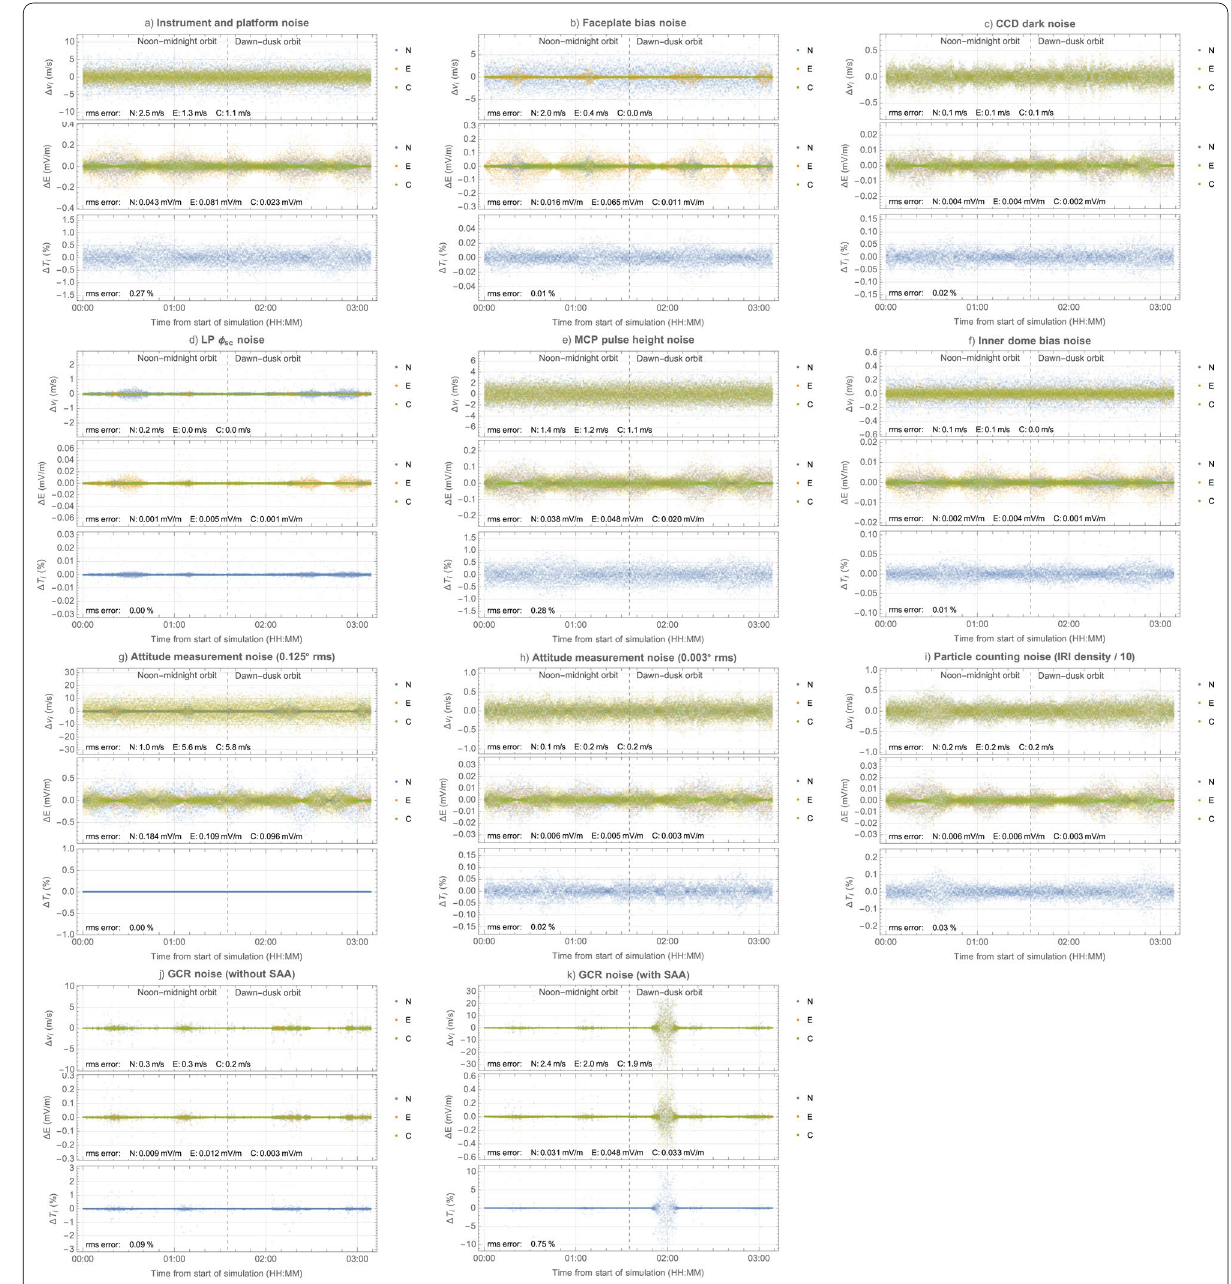
Fig. 26 Time series for random error sources estimated using the EES. For each error source, the plot shows errors in ion velocity (top panel), electric field (middle panel) and ion temperature (bottom panel). The dashed lines mark the artificial transition from a noon–midnight orbit to a dawn–dusk orbit. Data have been downsampled by averaging to the Nyquist frequency of 1 Hz